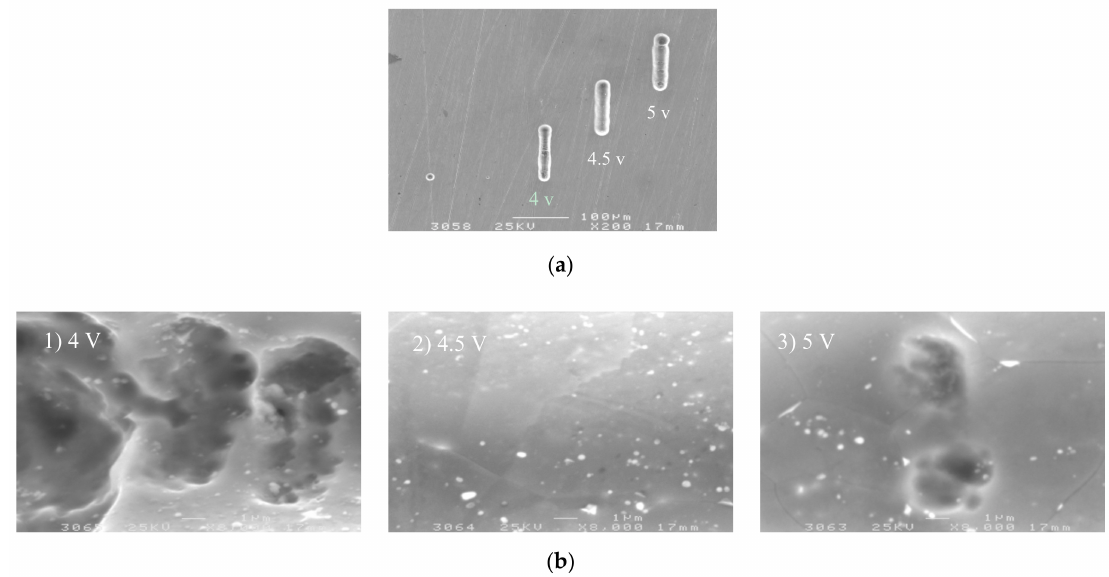
Figure 6. The microgroove under different voltages. ( a ) The SEM image of the microgroove; ( b ) The appearance of the